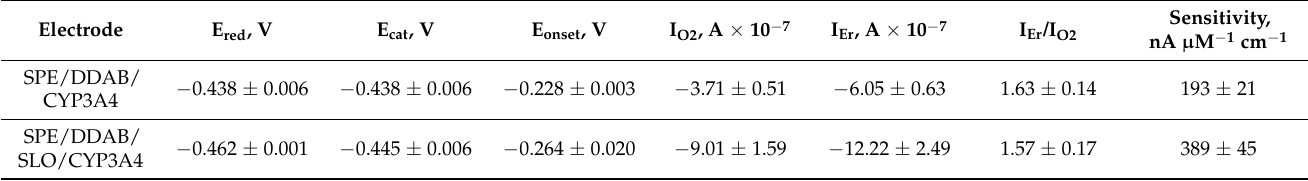
Table 2. Electrocatalytic parameters of CYP3A4 immobilized on SPE/DDAB and SPE/DDAB/SLO under aerobic conditions. The parameters were calculated at a scan rate of 0.1 V/s, and the concentra- tion of erythromycin is 100 µ M.